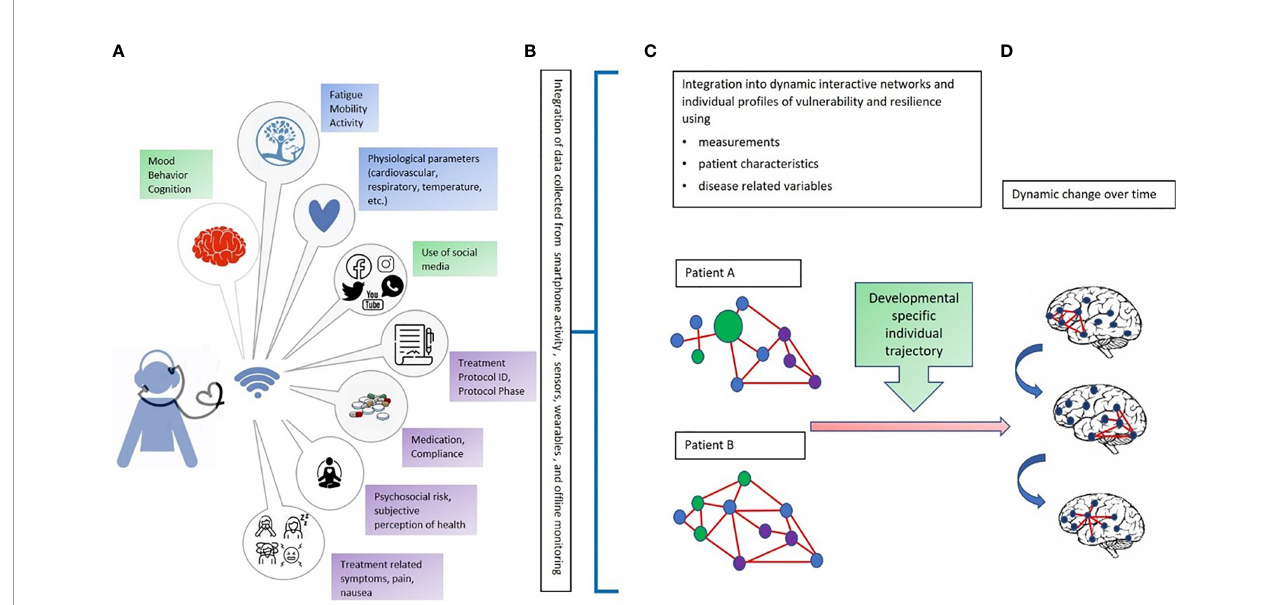
FIGURE 1 | An integrated multi-dimensional model for the use of digital phenotyping as part of a digital “ toolbox ” to be used in adolescents with cancer. Our hypothetical model is de fi ned over four phases: (A) The data collection phase: In green: Objective continuous non-invasive data collection related to mood, behavior, cognition, and use of social media (using a digital phenotyping app); in blue: Objective continuous non-invasive collection of biomarkers from sensors and wearables (heartrate, blood pressure, temperature); in purple: Periodic collection of subjective perceptions and impressions related to mental and physical wellbeing (e.g., diaries, self-reports, and questionnaires) and type of treatment, protocol, and protocol phase; (B) The data transformation phase, that is, the conversion of raw data into usable algorithms and outputs to feed data analysis and network construction; (C) Creation of individual networks based on data from different dimensions and domains to understand the strengths and needs of each patient. The circles represent signs, symptoms, and factors related to the domains of data collection (green, blue, and purple). The red lines represent the connections among signs, symptoms, and factors; (D) Development of dynamic networks to monitor change over time in network organization and connectivity aimed at identifying windows of vulnerability and resilience. Letters and colors refer to those shown in the fi